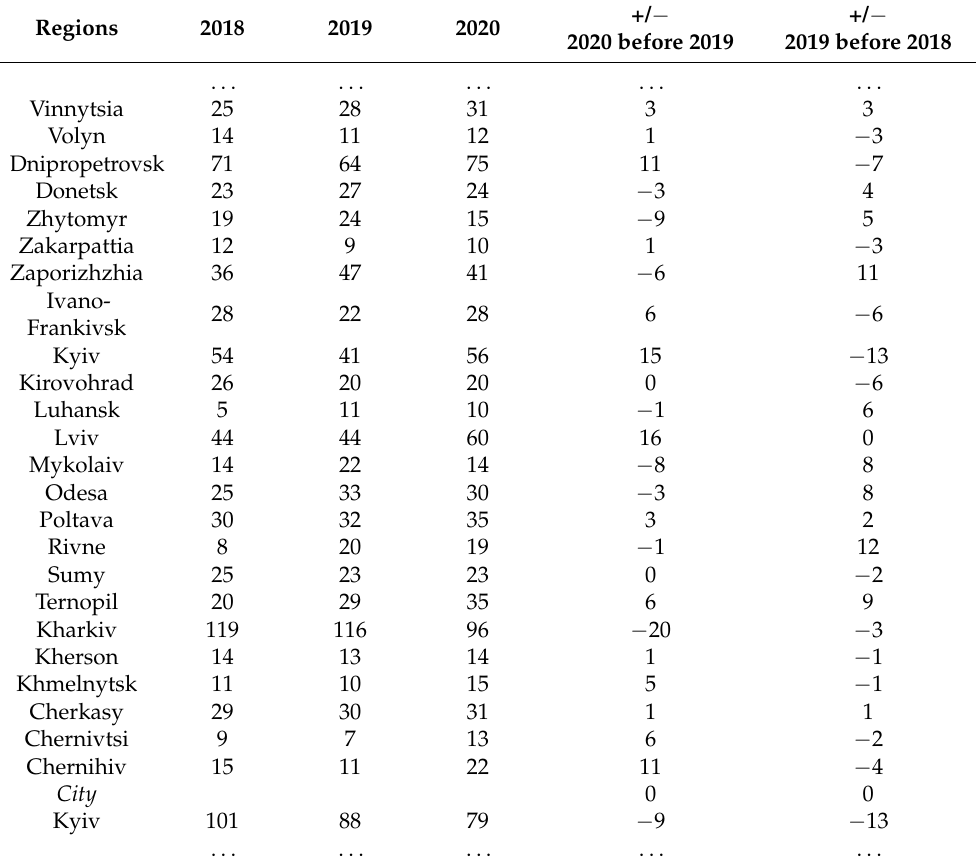
Table 2. Regions of Ukraine by number of innovation-active enterprises [33].